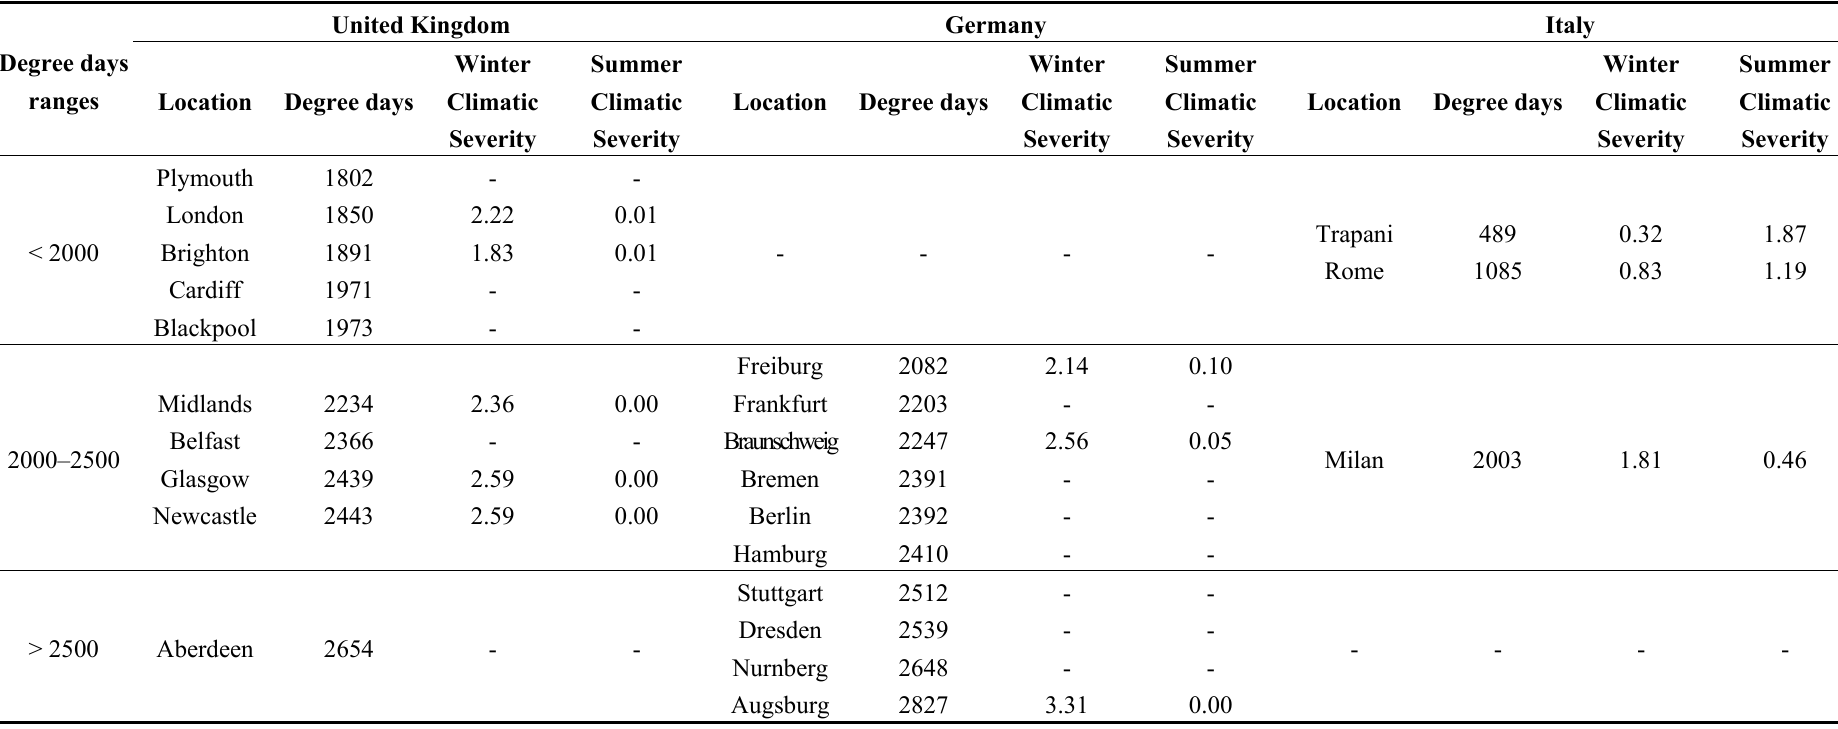
Table 1. Heating degree days (degreedays.net) with 15.5 °C set temperature for selected locations in Germany, UK and Italy and the Climate Severity Index figures are taken from the Passive-on program report